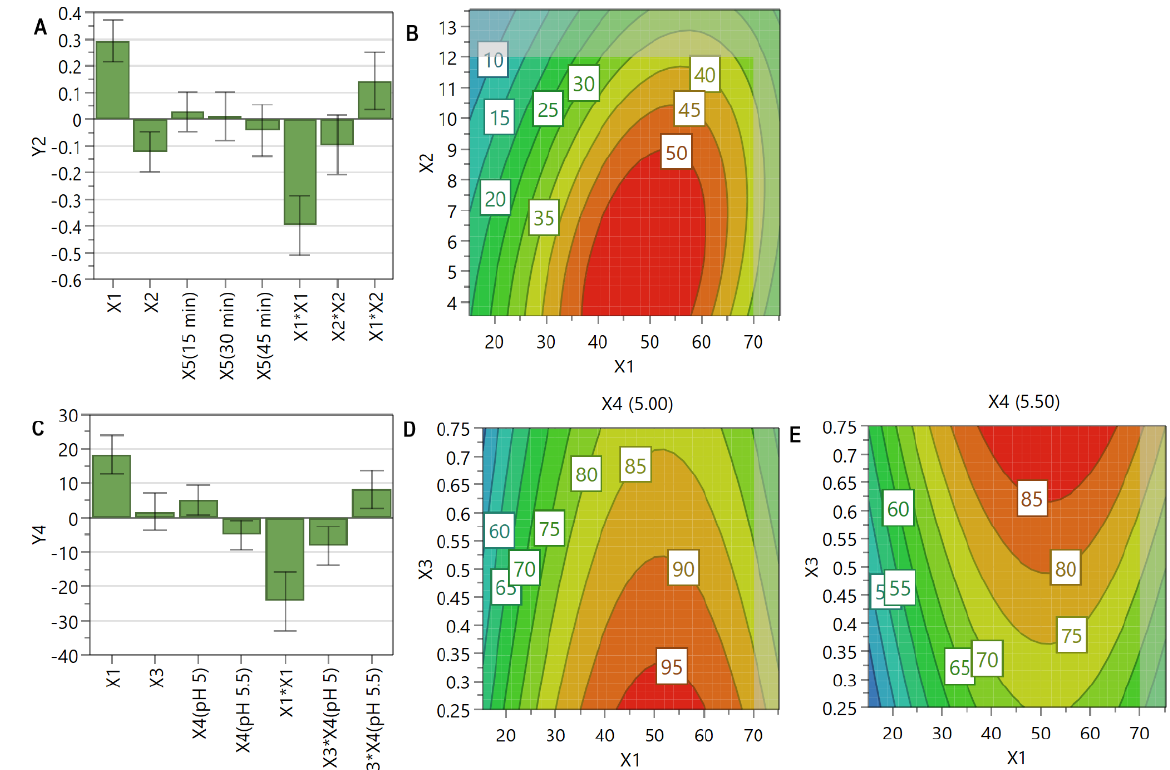
Figure 3. The coefficient plots for SIM ( A ) and DOX ( C ) EE% showing the significance of formulation factors in respect to these responses. The response contour plots for SIM ( B ) and DOX EE% when the pH of the AS solution was 5.00 ( D ) or 5.50 ( E ) showing the variance of experimental results in respect to PL concentration (X1), SIM concentration (X2), DOX concentration (X3), and the pH of the AS solution (X4). X1: PL concentration (mM); X2: SIM concentration (mM); X3: DOX concentration (mM); X4: the pH of the AS solution; X5: incubation time with DOX (min); Y2: SIM EE% (%); Y4: DOX EE%